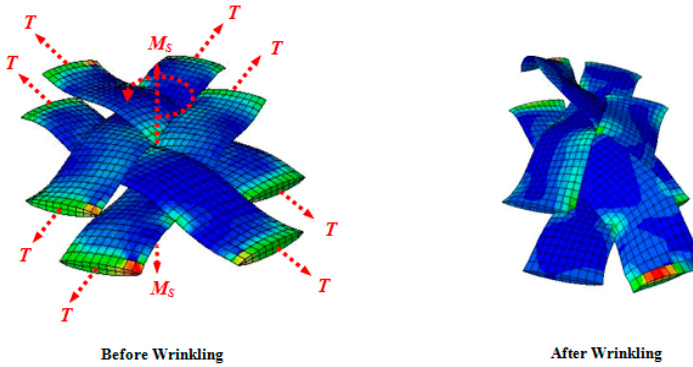
Figure 5. Mechanism of wrinkle formation in a PWCP representative element due to large in-plane shear deformation ( T and M s denote the tension along yarn and in-plane shear coupling, respectively).